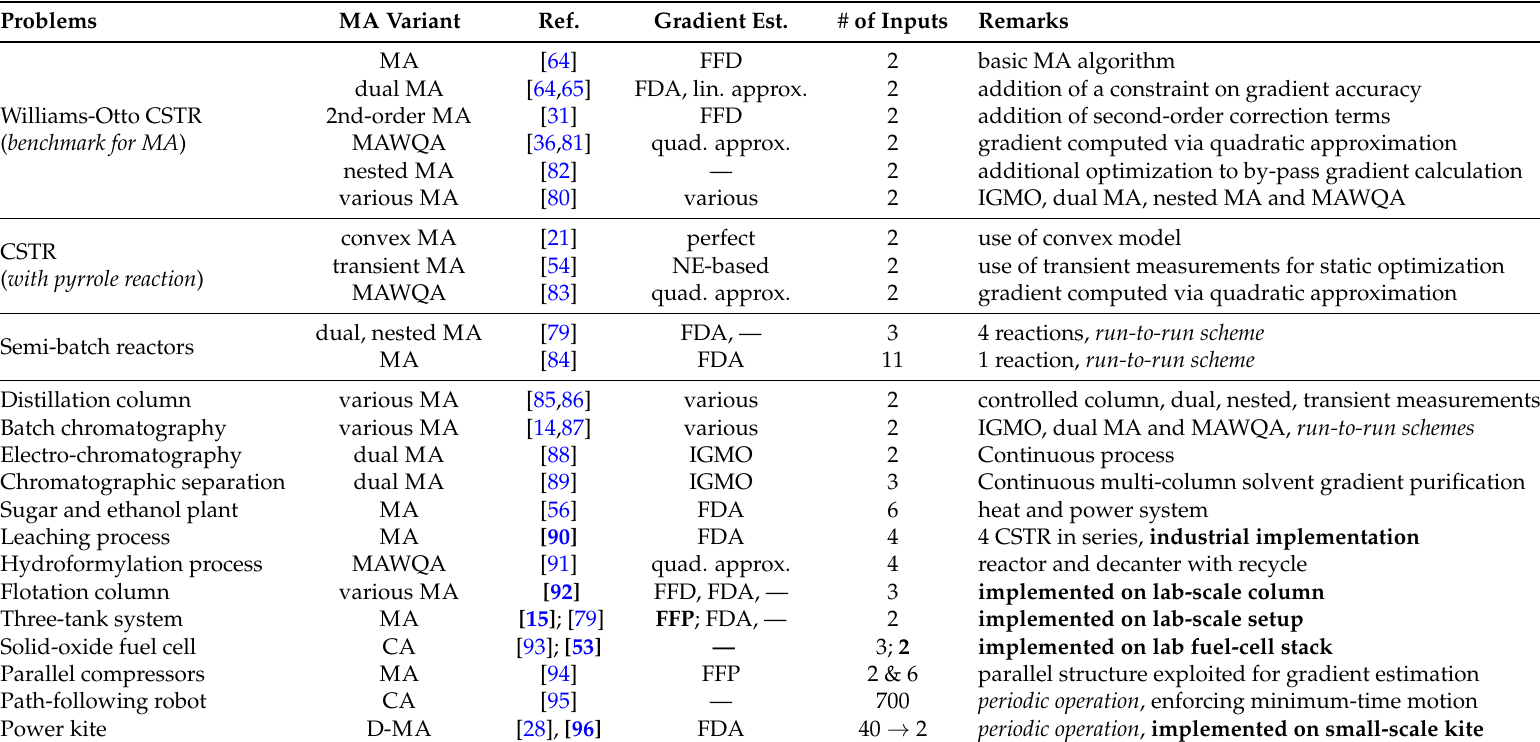
Table 1. Overview of MA case studies ( FFD : forward finite difference with input perturbation; FDA : finite-difference approximation based on past and current operating points; NE : neighboring extremals; CA : Constraint Adaptation; MAWQA : MA with quadratic approximation; IGMO : iterative gradient-modification optimization, where gradients are estimated via FDA with added perturbation when necessary; in bold: experimental implementation